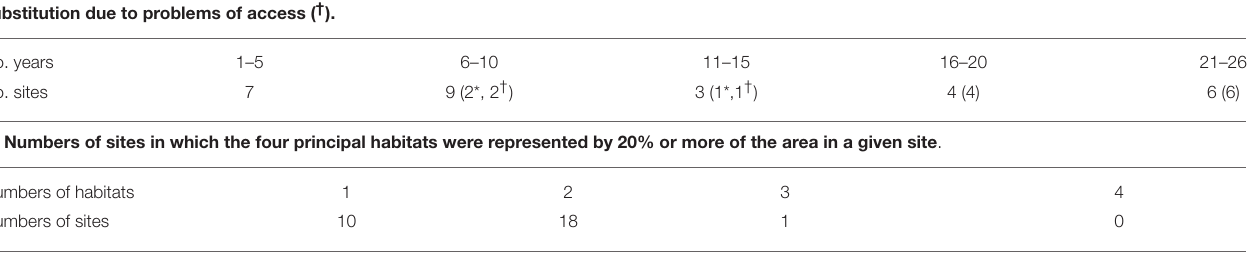
TABLE 1 | Characteristics of the 29 sites censused during the 26 years of the Sabana de Bogotá Audubon’s Christmas Bird Count (1989–2014). A. Numbers of years a site was censused: in parentheses, the number of sites designated as priority (*) and the number of sites requiring substitution due to problems of access ( †